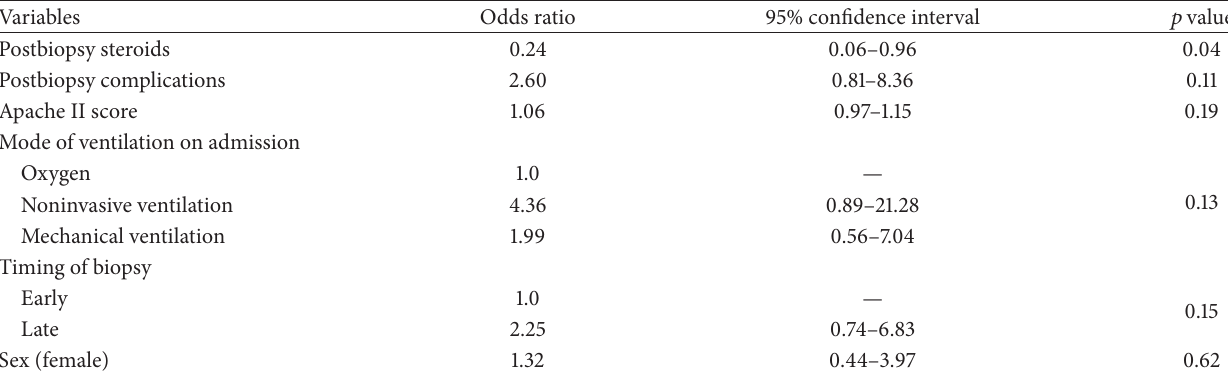
Table 4: Multivariable analysis of clinical variables associated with acute hospital